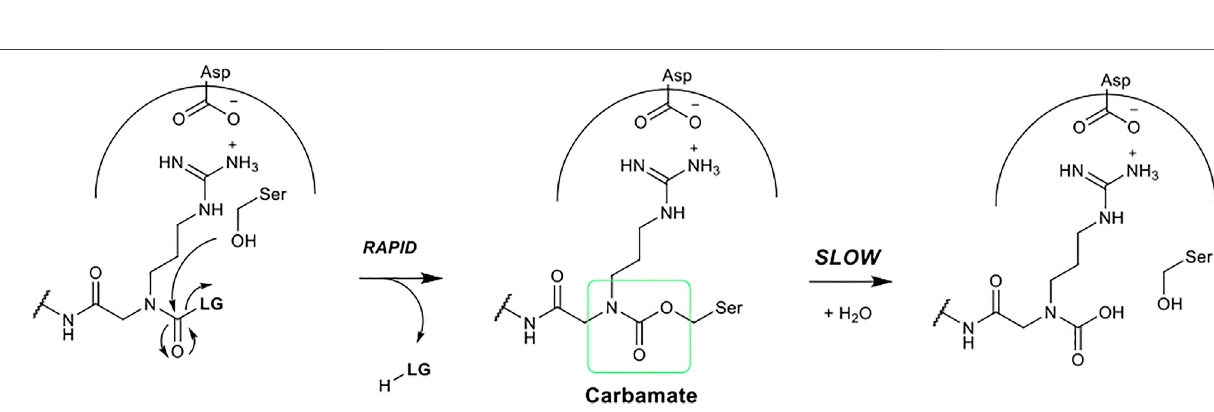
Frontiers in Chemistry |